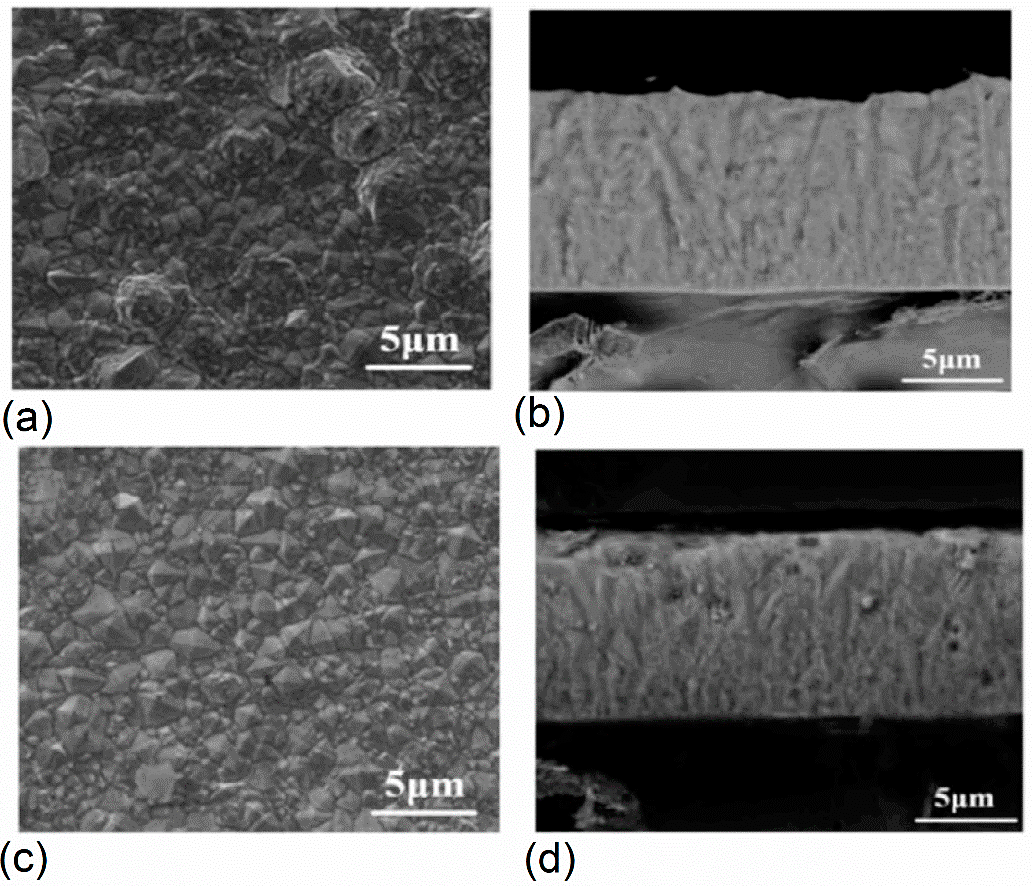
Figure 2. Surface morphologies and cross-sectional SEM micrographs (backscattered electrons mode) of Ni films plated at current densities: ( a , b ) 1.5 A/dm 2 ; ( c , d ) 3.5 A·dm − 2 .